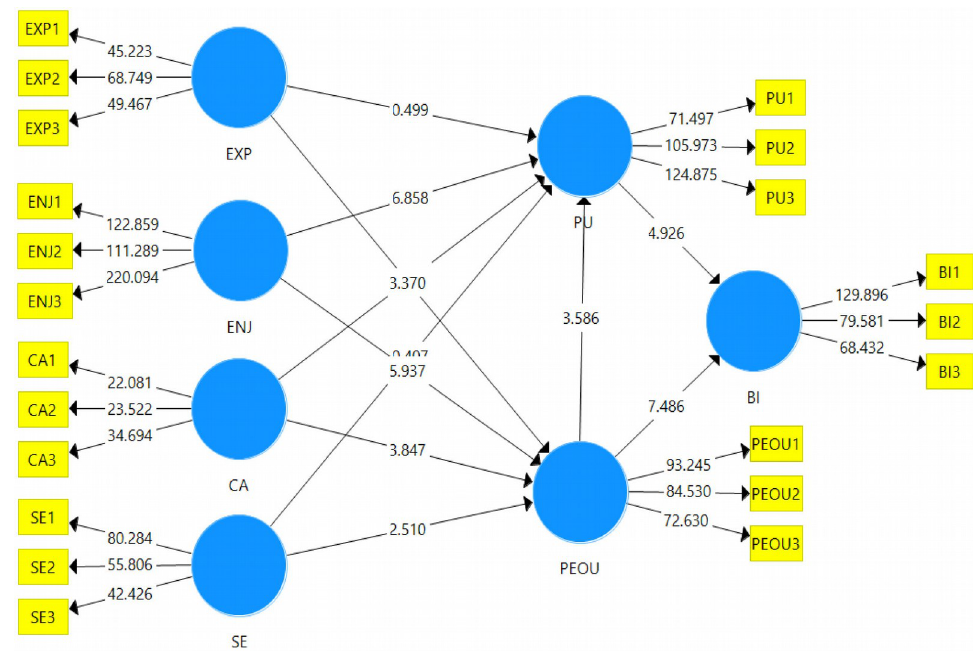
Figure 2. Measurement and Model